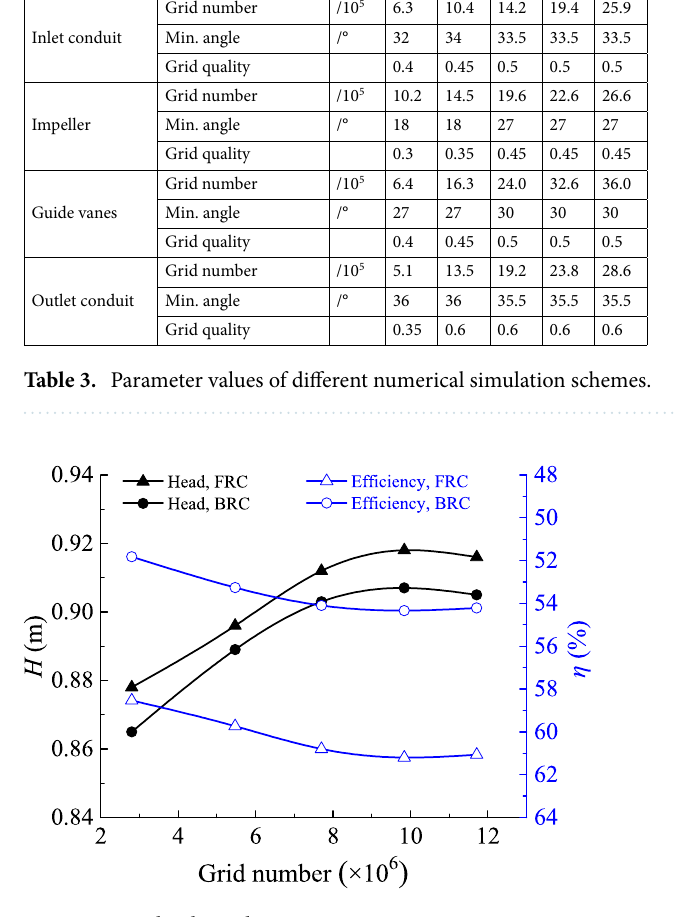
Figure 3. Grid independency